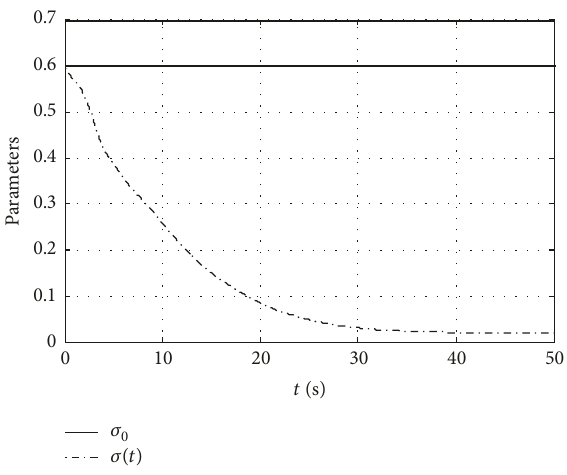
Figure 11: The threshold parameters in Cases 1 and 2.